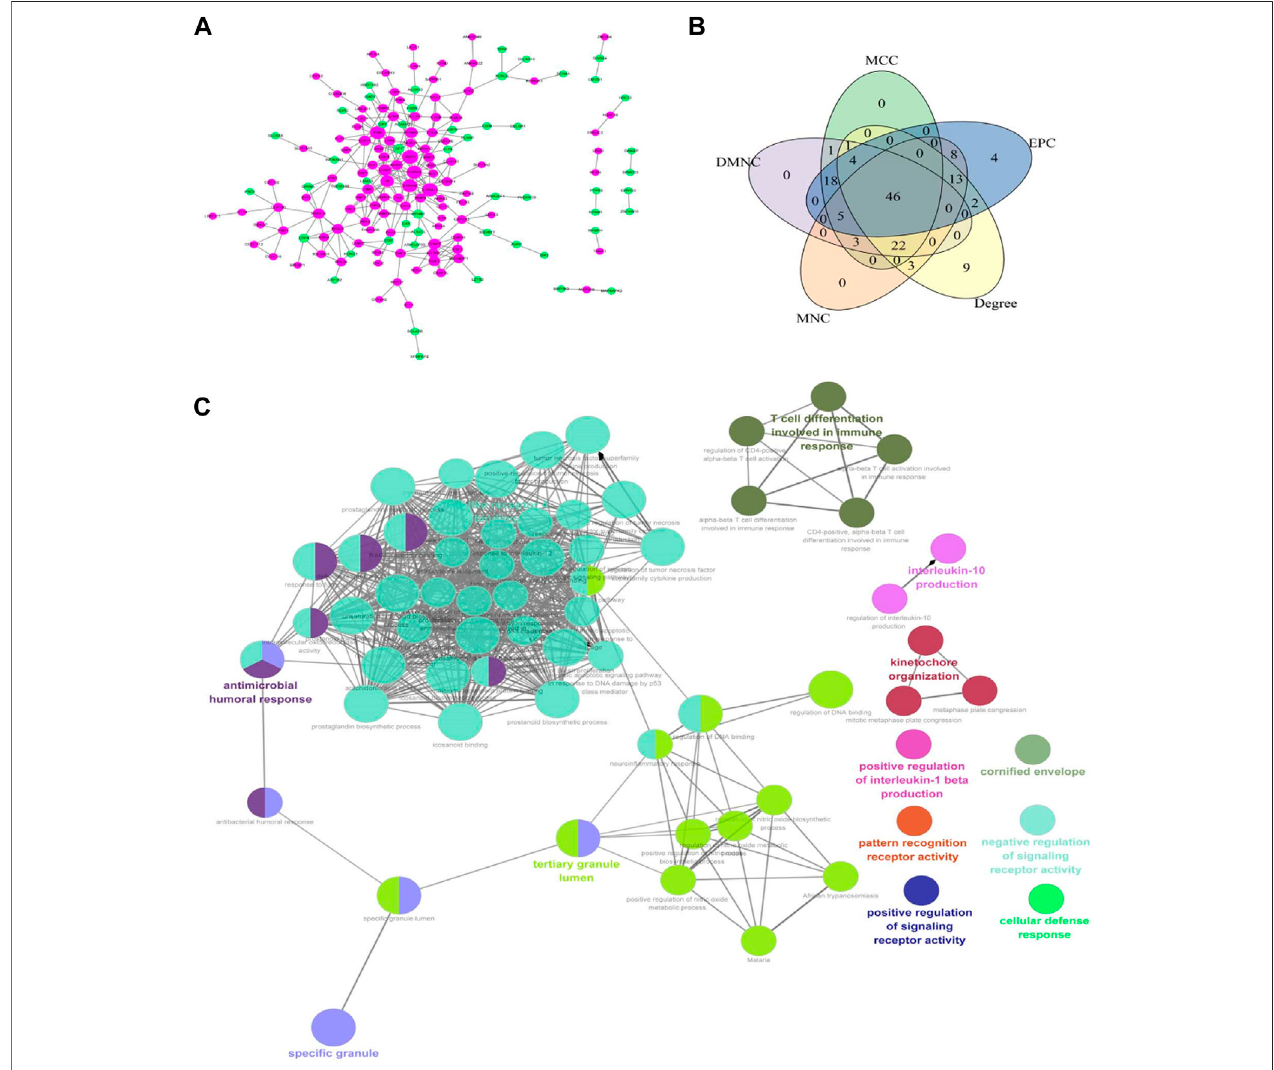
FIGURE 4 | (A) Protein interaction network of differential genes. Magenta is an upregulated gene and green is a downregulated gene. The greater the node connectivity, the larger the node; (B) Core gene screening; (C) ClueGO network of terms/pathways.